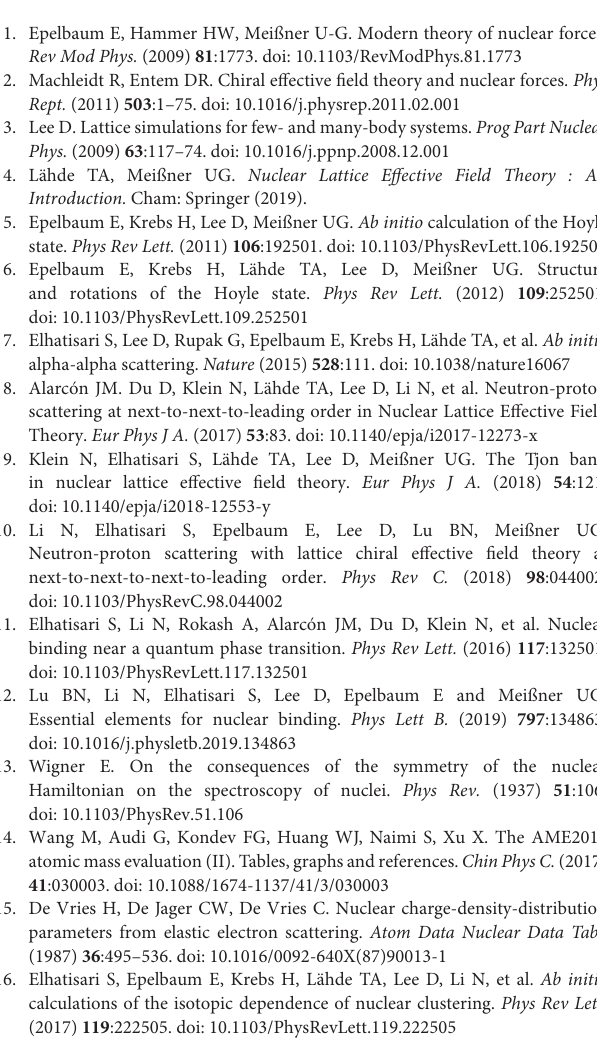
Figure S1 | Results for the neutron-proton scattering phase shifts and mixing angles vs. the relative momenta for lattice spacing a = 1.32 fm. The blue, green and red bands show the estimated uncertainties at NLO, N 2 LO and N 3 LO respectively. The black solid line and diamonds denote phase shift or mixing angle from the Nijmegen partial wave analysis and lattice calculation at N 3 LO, respectively. Figure from Li et al. [10]. Figure S2 | Results for the neutron-proton scattering phase shifts and mixing angles vs. the relative momenta for lattice spacing a = 0.99 fm. The blue, green and red bands show the estimated uncertainties at NLO, N 2 LO and N 3 LO respectively. The black solid line and diamonds denote phase shift or mixing angle from the Nijmegen partial wave analysis and lattice calculation at N 3 LO, respectively. Figure from Li et al. [10].